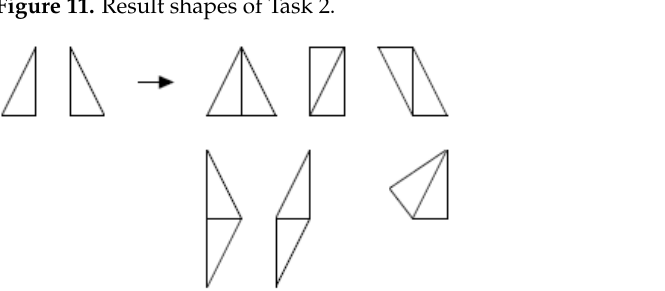
Figure 12. Example of ‘Making new figures’ from [25].